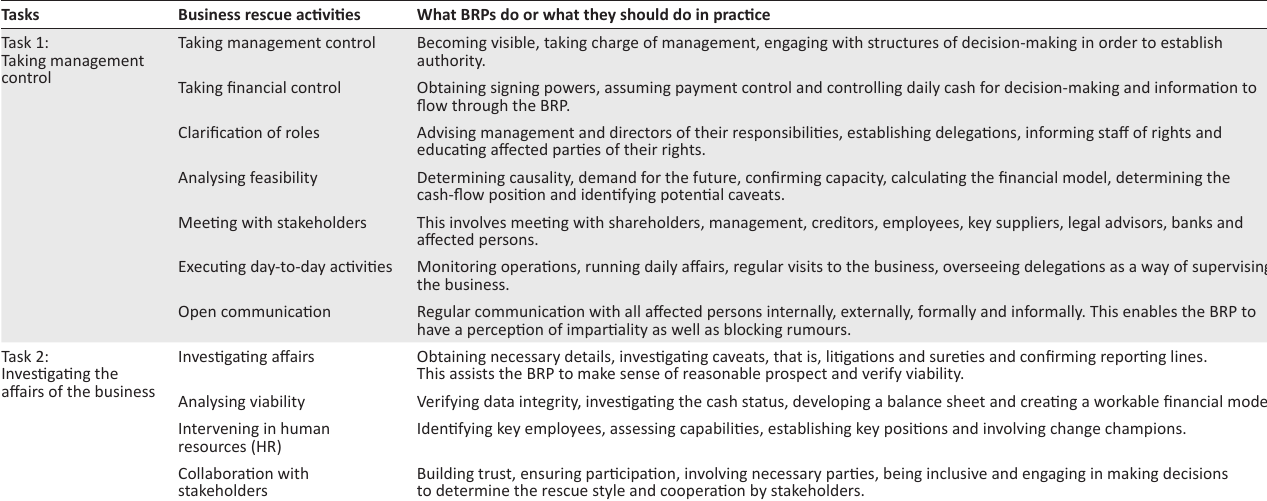
TABLE 1: Business rescue practitioner tasks, activities and activity explanations. Tasks Business rescue